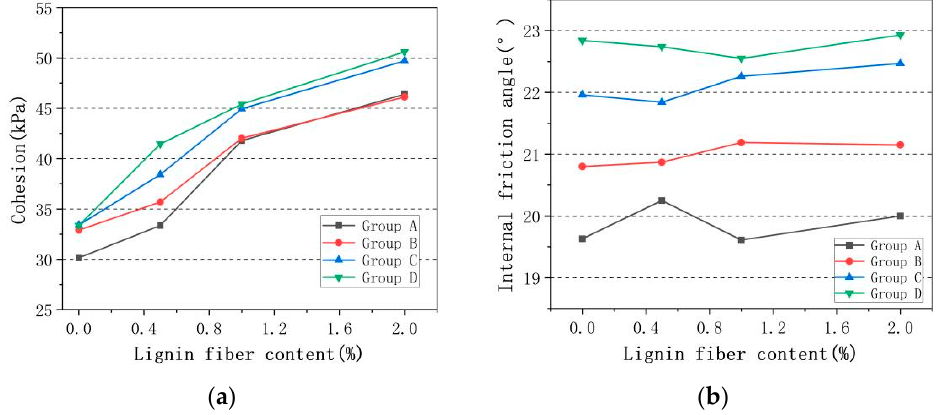
Figure 4. Variation curve of cohesion and internal friction angle with lignin fiber: ( a ) variation curve of cohesion with lignin fiber; ( b ) curve of internal friction angle with lignin fiber.